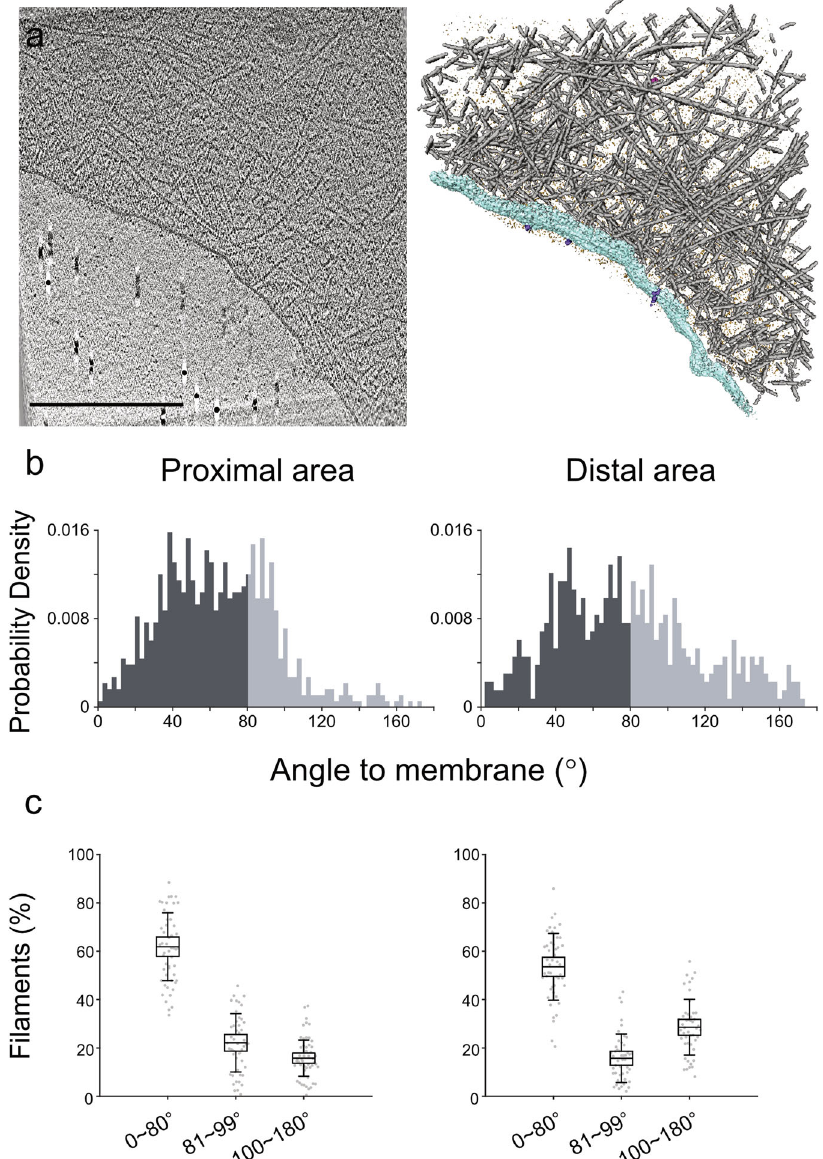
Fig. 3 Filament network and fi lament-membrane orientation. a An x-y slice through a cryo- tomogram (left) and its rendered isosurface view of a lamellipodium protrusion. Actin fi laments (gray), cell membrane (turquoise), membrane receptors (purple), and cell components (magenta). Scale bar: 300 nm. b The orientation of fi laments with respect to the membrane was measured in 47 tomograms at the membrane proximal area of the cells (0 – 40 nm away from membrane) and distal area (360 – 400 nm away from membrane). The dark gray region represents fi laments that contain vectorial components with the barbed end towards the membrane. c The boxplots showing the proportion of the different fi lament directionalities with respect to the membrane, with 1 SD and 1.96 SEM in whiskers ( N = 47